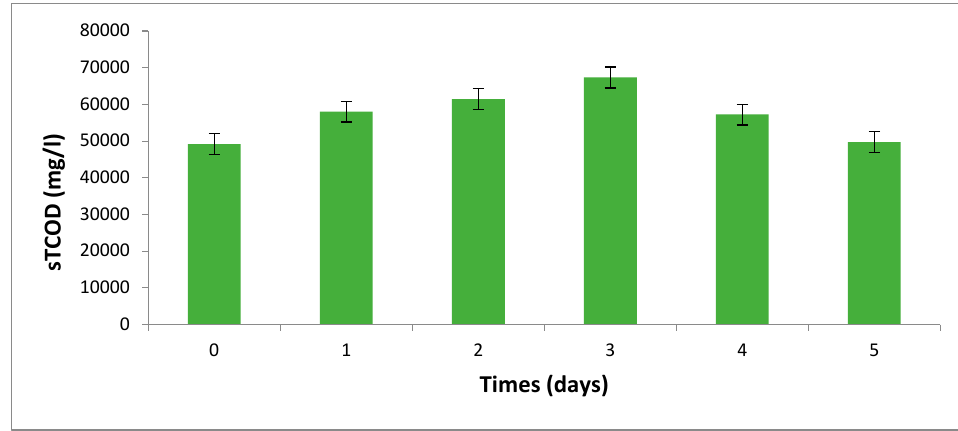
Figure 6. Changes in total soluble chemical demand (sTCOD) of food waste hydrolysis by OFAT.